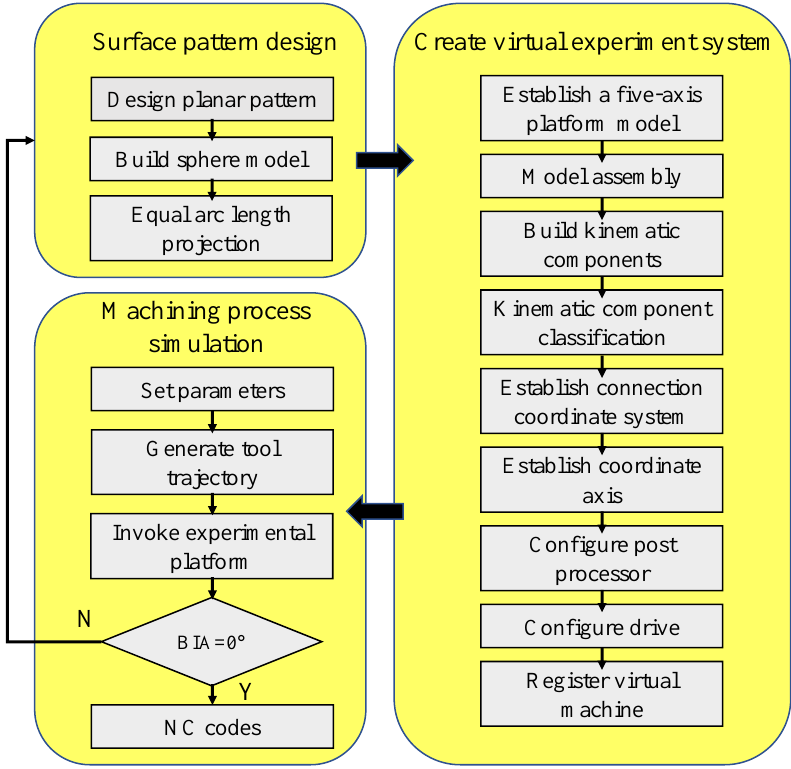
Figure 4. Flowchart of digital simulation of MALM of non-planar surface.